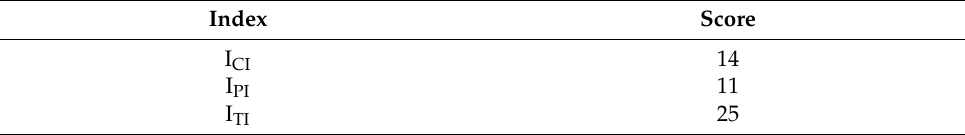
Table 5. Total inherent safety